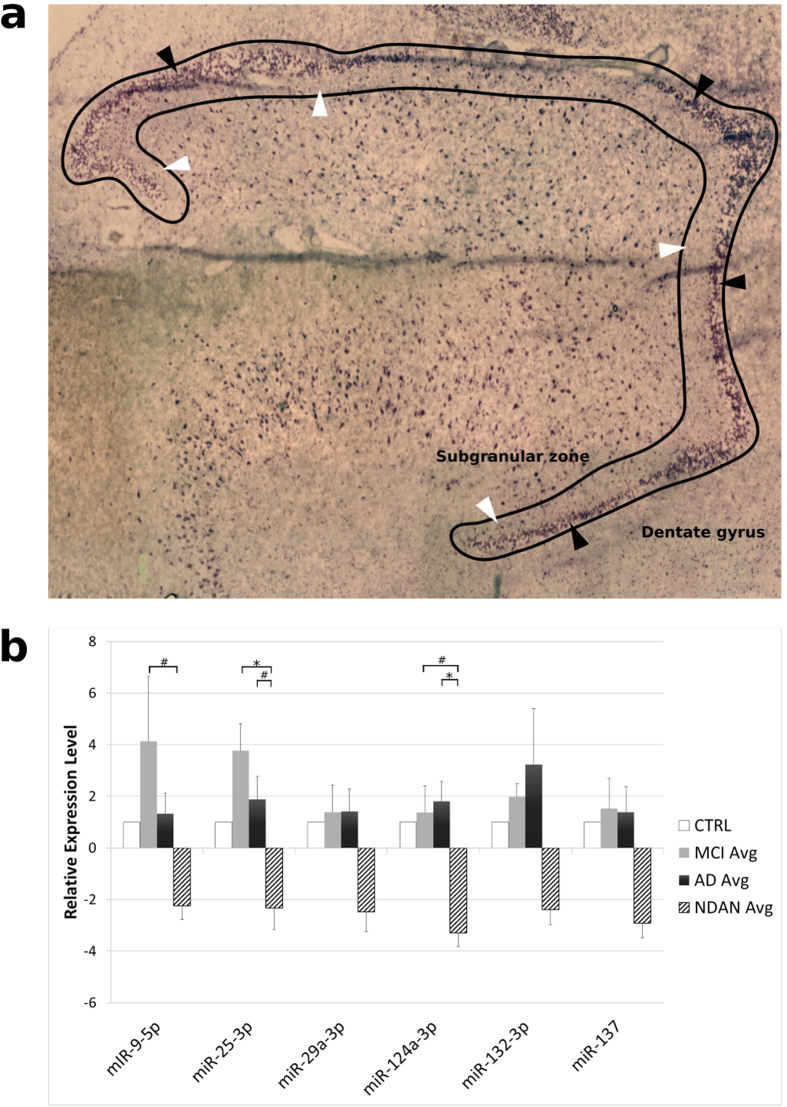
The expression of selected miRNAs in the DG is significantly different between non-demented and demented individuals with AD pathology.(a) Representative section of human DG stained with cresyl violet. The black outline indicates the region collected by laser capture microdissection (LCM). Black arrowheads (▲) indicate the granular cell layer (GCL). White arrowheads indicate the subgranular zone (SGZ). (b) The relative level of expression of six miRNAs, known to play a role in the regulation of neurogenesis, was determined in the DG by qRT-PCR and fold changes were calculated using the 2−ΔΔCt method. Age-matched healthy controls were used as calibrator, with its fold change taken as 1. The relative expression of all evaluated miRNAs between groups was found to be significantly less in NDAN than both MCI (Q = 1.507, p < 0.001) and AD patients (Q = 5.247, p < 0.001; One Way ANOVA). For each miRNA, statistical analysis was performed by one-way ANOVA followed by pairwise multiple comparison procedures using the Holm-Sidak method, #p <0.05, *p <0.01.